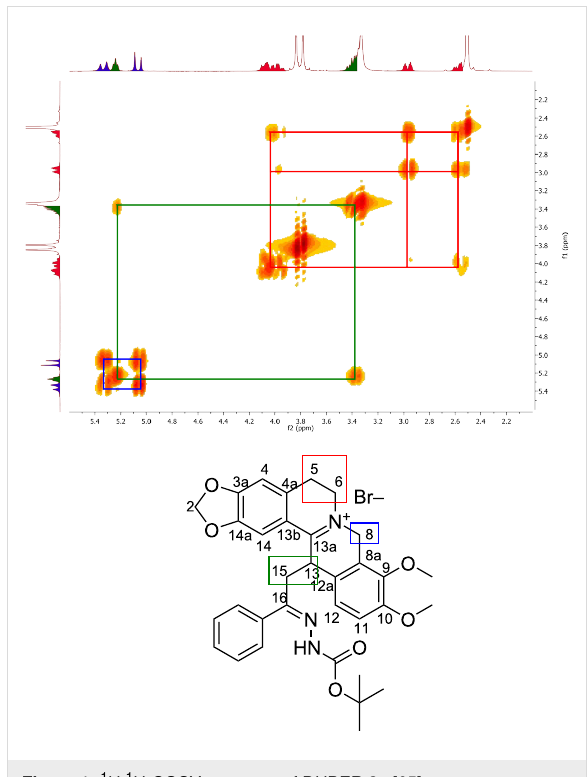
Figure 1: 1 H, 1 H-COSY spectrum of DHBER 2a [65].